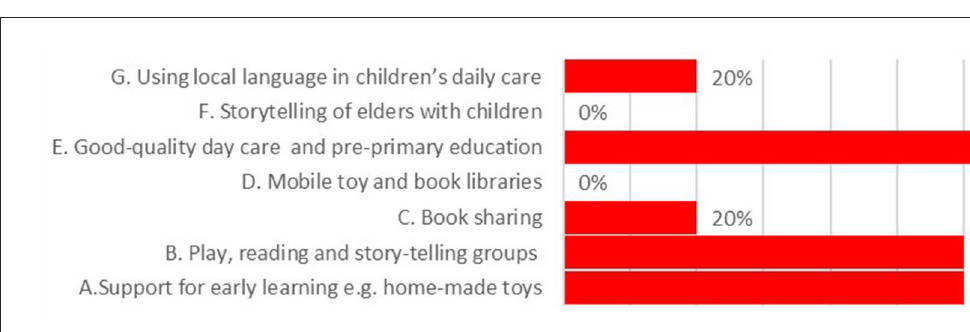
FIGURE8 Coverage of “Opportunities for Early Learning” in national policies.